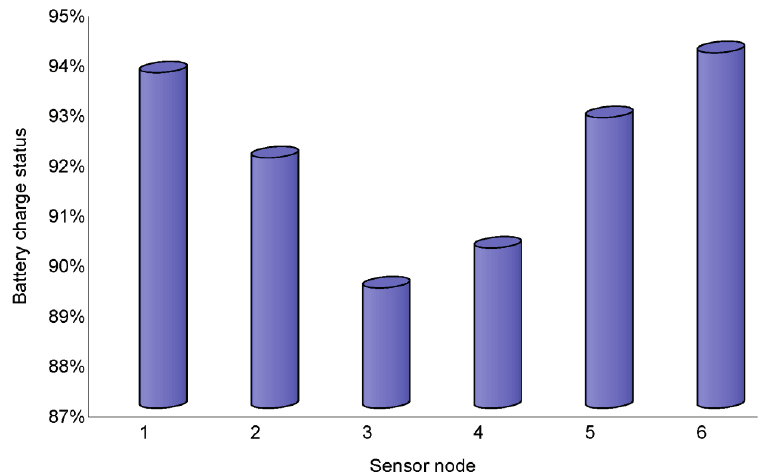
Figure 15. Battery charge status of the sensor nodes in the